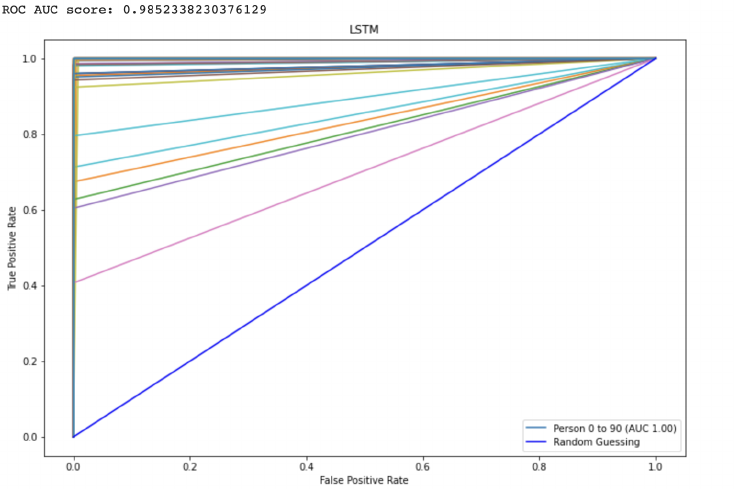
Figure 9. Represents the area under the curve score for proposed LSTM model.